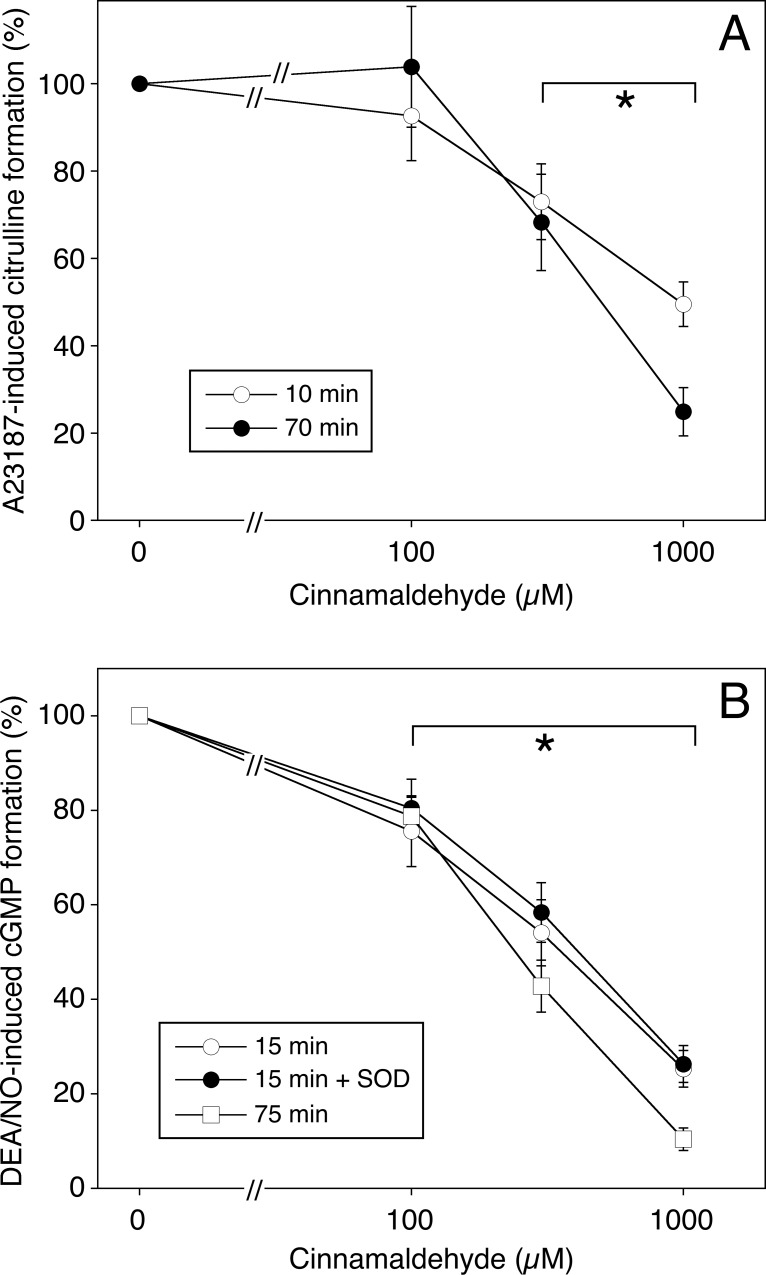
Concentration dependent effect of cinnamaldehyde on endothelial L-citrulline and cGMP formation.A, Endothelial cells were preincubated with increasing concentrations of cinnamaldehyde for 10 min in incubation buffer (open circles) or for 60 min in culture medium and 10 min in incubation buffer (filled circles). Then, cells were stimulated with 1 μM A 23187 (1 μM), and L-citrulline was determined as described under Materials and Methods. Data were normalized to the conversion of L-[3H]arginine into L-[3H]citrulline measured in non-pretreated cells (= 100%) and are expressed as mean values±SEM (n = 4). B, Endothelial cells were preincubated with increasing concentrations of cinnamaldehyde for 15 min in incubation buffer in the absence (open circles) and presence of 1000 U/ml SOD (filled circles), or for 60 min in culture medium and 15 min in incubation buffer. Then, cells were stimulated with DEA/NO (1 μM) and cGMP formation was determined. Data were normalized to cGMP production measured in non-pretreated cells (= 100%) and are expressed as mean values±SEM (n = 4). *p<0.05 vs. controls in the absence of cinnamaldehyde (ANOVA with Dunnett's post hoc test).